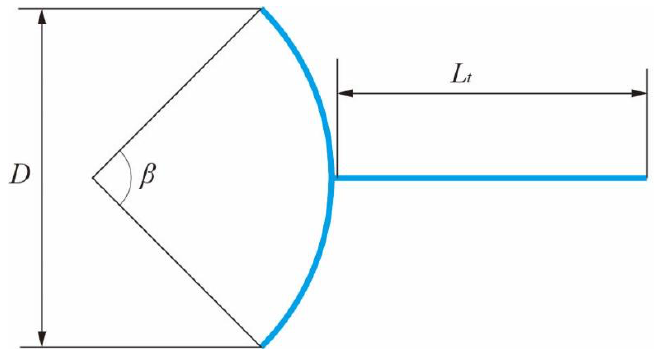
Figure 2. Arc-plate-shaped bluff body.